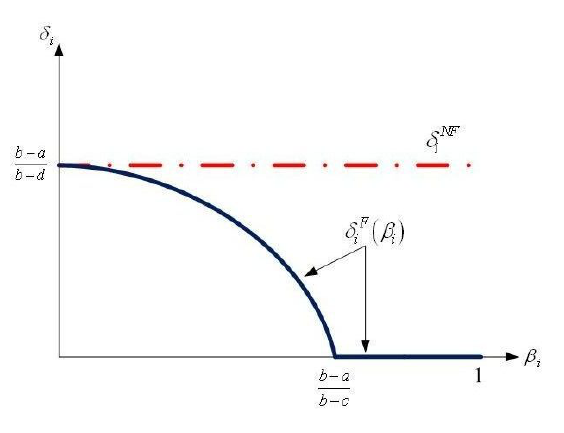
( β ) and δ NF i i i